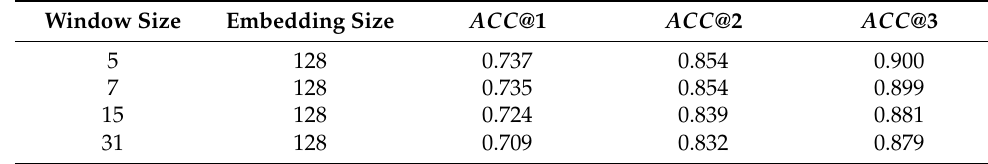
Table A5. Results for the best LBERT-FT model with different window sizes. Window